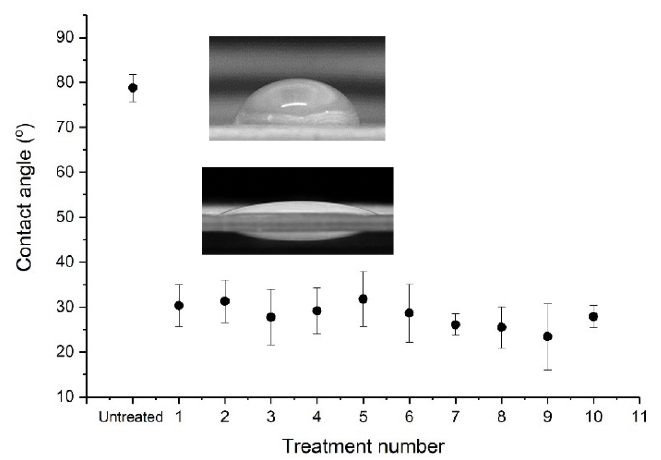
Figure 5. Contact angles of untreated and treated GFPA6 from 1–10 treatments.